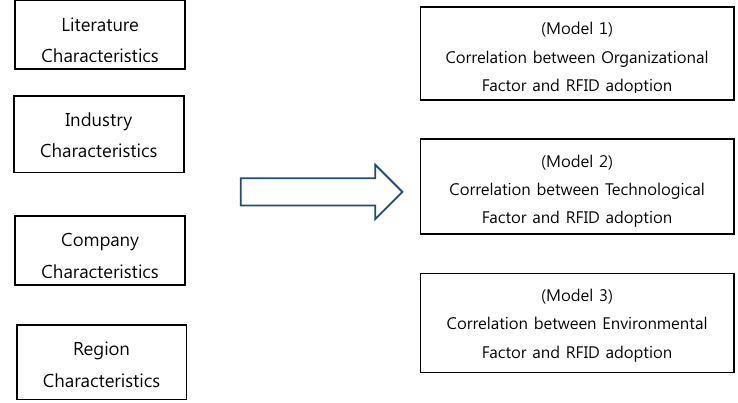
Figure 3. Analytical frame for meta-SUR